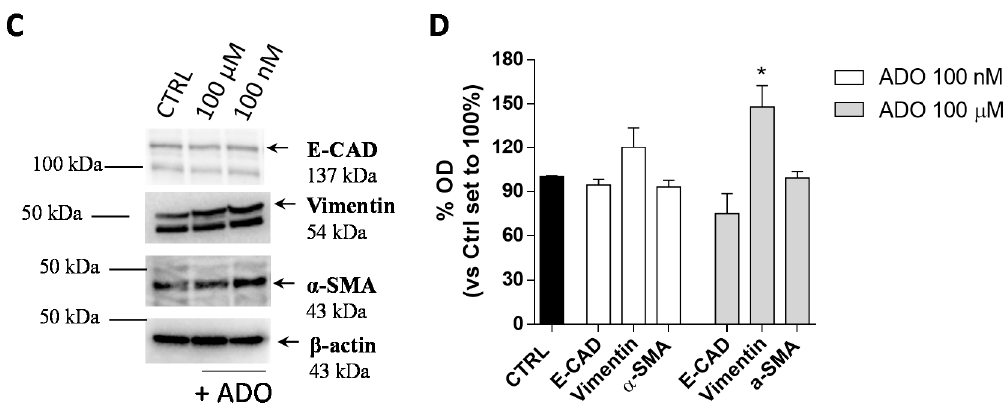
Figure 2. ADO modulation of GMT process in glioma cells. U343MG cells were treated with ADO (100 nM or 100 µM) for 72 h. ( A , B ) The mRNA expression levels of GMT master genes (Slug, Snail, Twist and ZEB1) ( A ) and the epithelial (CDH1) and mesenchymal (Vimentin and ACTA2) markers ( B ) were determined by Real-Time RT-PCR. The data are expressed as fold changes with respect to basal value set to 1 and are the mean values ± SEM of two independent experiments. ( C , D ) U343MG cells were treated as described above and the protein expression of Epithelial (E-CAD) and Mesenchymal markers (Vimentin and α -SMA) were evaluated by Western blotting. ( C ) One representative blot for each protein is presented and ( D ) the bar graph shows the densitometric analysis of the Western blot performed using ChemiDocTM XRS + System (BioRad, Hercules, CA, USA). The data are expressed as the fold change vs. the CTRL levels, which were set to 1 and are the mean values ± SEM of three di ff erent experiments. The significance was determined by one-way ANOVA, followed by Bonferroni’s post hoc test: * p < 0.05, ** p < 0.01 vs. CTRL.